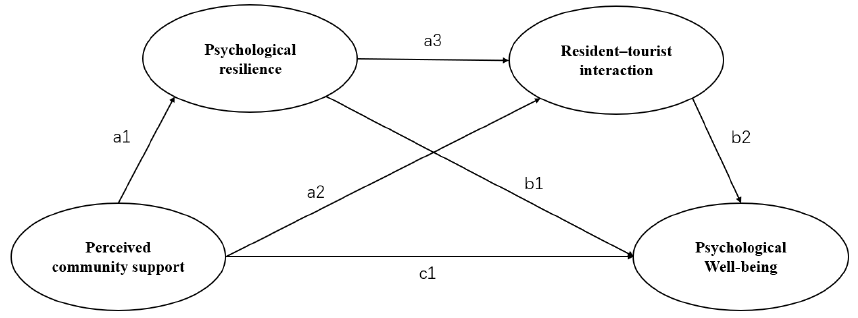
Figure 1. Conceptual framework.